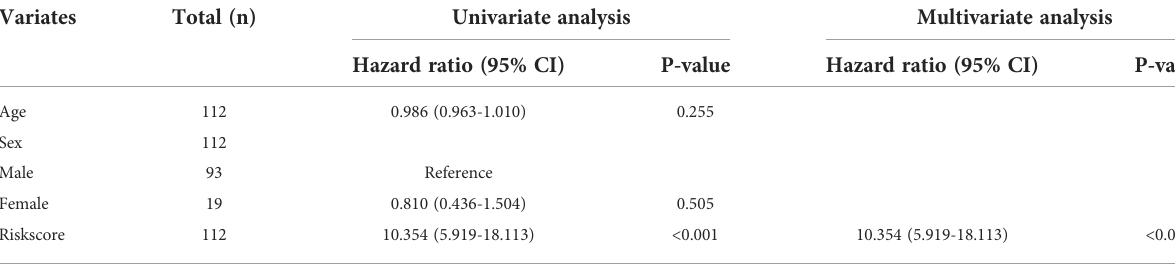
TABLE 2 Univariate and multivariate analysis of Riskscore and characteristics in the training cohort.